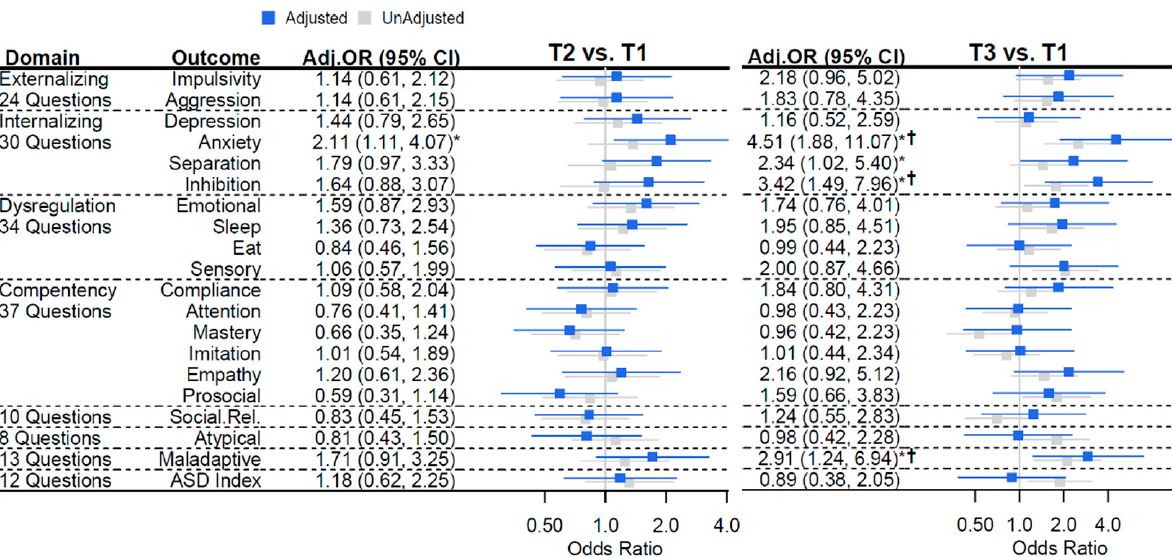
For each tertile of MGL (maternal glycemic loading), mean (sd) and N are reported for birth weight, birth height, weight gain per month, and height gain per month. The mean (sd) for height and weight gains reported for offspring where an assessed follow-up value existed within 4 months of the ITSEA (Infant-Toddler Social and Emotional Assessment).